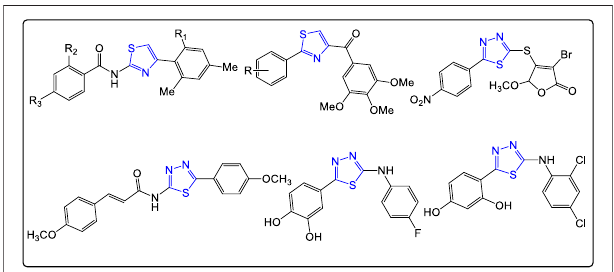
FIGURE 1 | Lead compounds among thiazoles and thiadiazoles with anticancer activities.